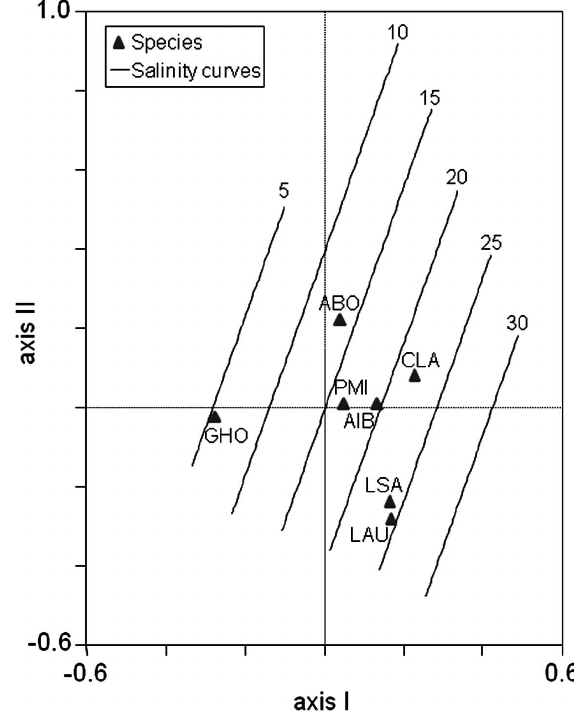
f ig . 5. – Species attribute plot showing salinity curves and the spe- cies preferences. Species abbreviations: ABO ( Atherina boyeri ), AIB ( Aphanius iberus ), CLA ( Chelon labrosus ), GHO ( Gambusia holbrooki ), LAU ( Liza aurata ), LSA ( Liza saliens ) and PMI ( Poma- toschistus microps